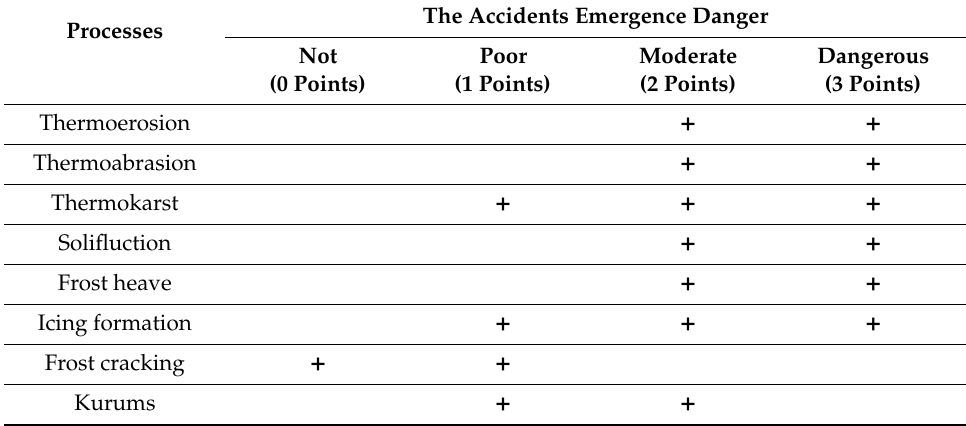
Table 4. The assessment of the degree of work safety at engineering